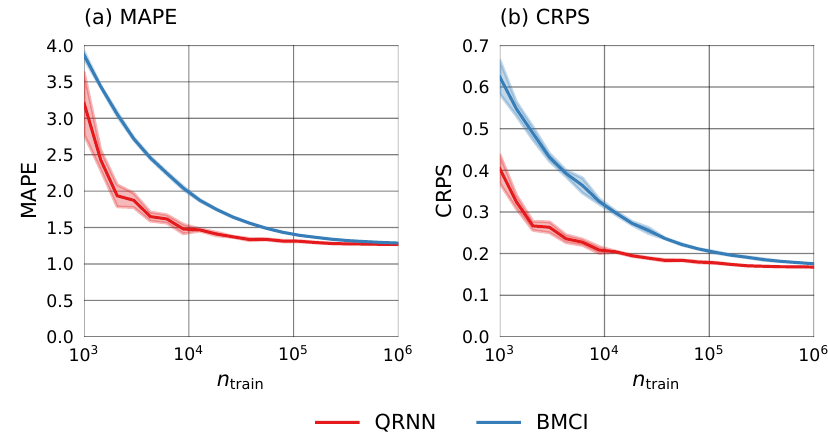
Figure 6. MAPE (a) and CRPS (b) achieved by QRNN (red) and BMCI (blue) on the test set using differently sized training sets and retrieval databases. For each size, five random subsets of the original training data were generated. The lines display the means of the observed values. The shading indicates the range of ± σ around the mean.